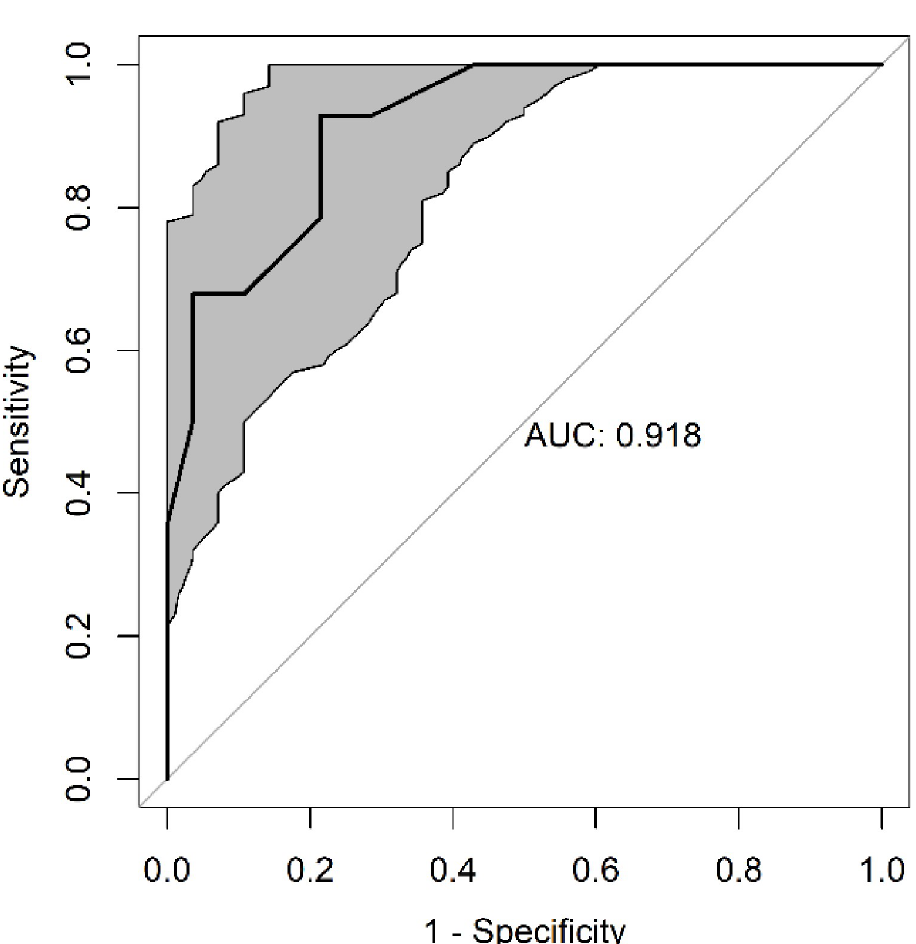
Fig 9. Receiver Operating Characteristic (ROC) curve and area under the curve (AUC) of the UPAPS applied to castrated piglets awake (n = 14). AUC values above 0.90 represent high discriminatory capacity (accuracy) of the scale [37]. The gray region represents the 95% confidence